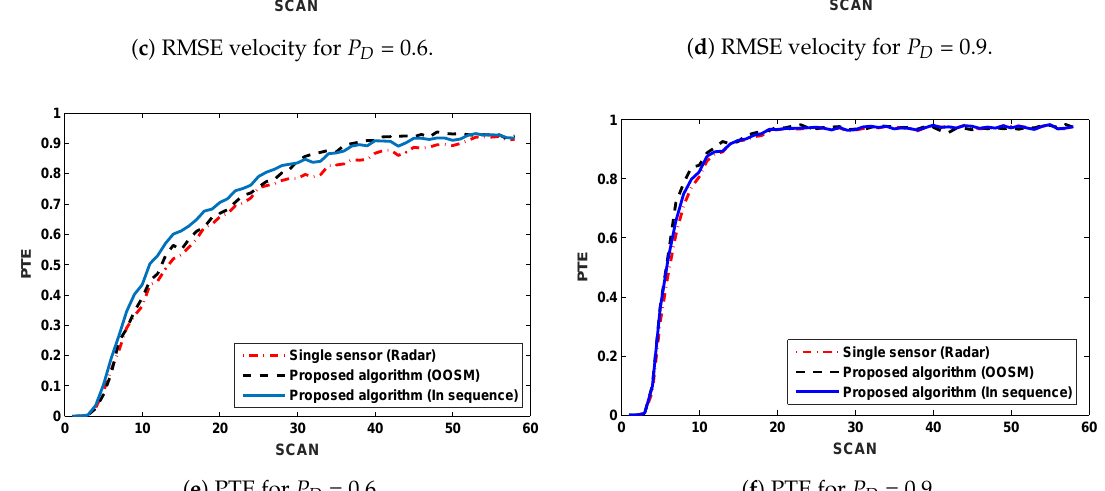
( f ) PTE for P D = 0.9.